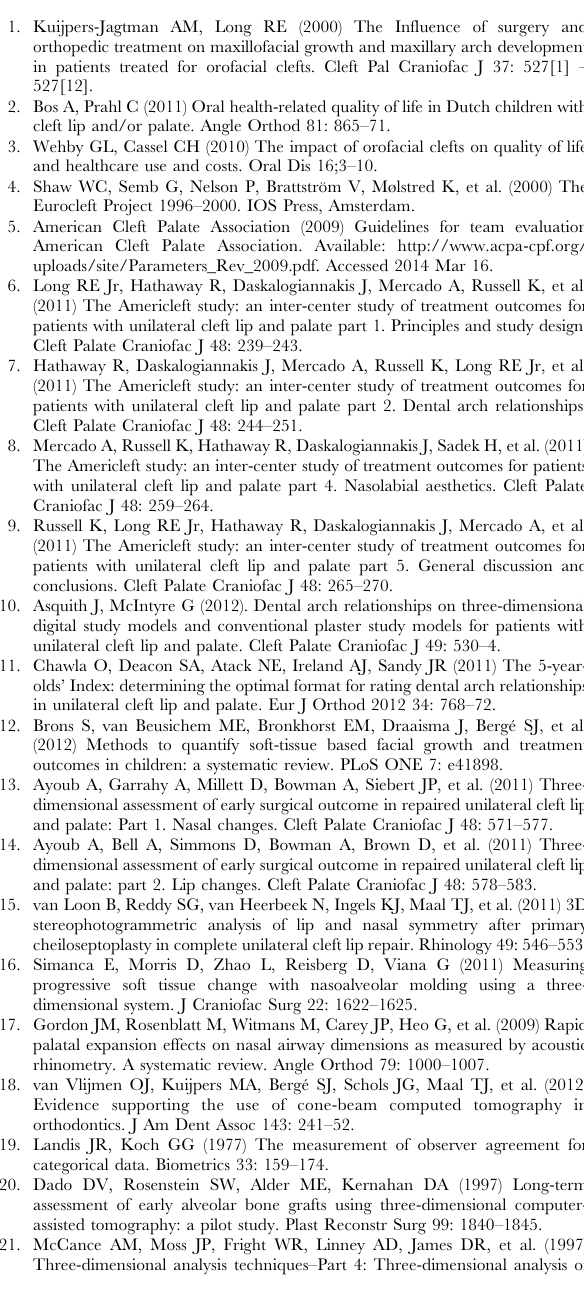
Table S4 Methodological quality scores of stereophotogramme- try studies. Table S5 Methodological quality scores of laser surface scanning studies. Table S6 Methodological quality scores of other